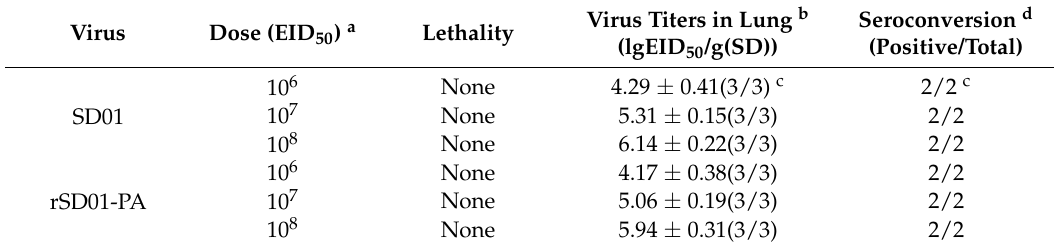
Table 2. Virus replication ability in the lung tissue of the SPF